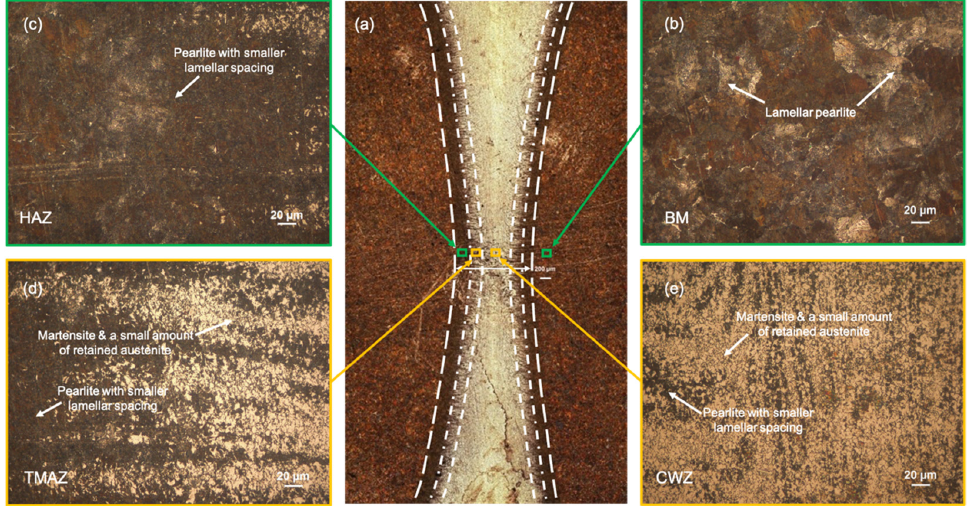
Figure 6. Optical micrographs of different subzones of CDFW joint. ( a ) Macrographic section, ( b ) BM, ( c ) HAZ, ( d ) TMAZ, ( e ) CWZ. ( c ) HAZ, ( d ) TMAZ, ( e )